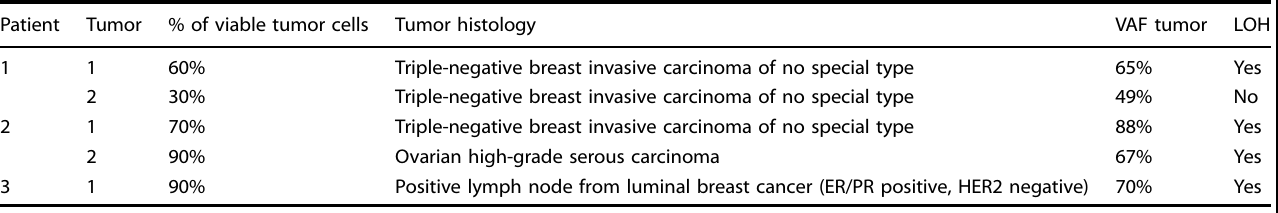
Table 5. Loss of heterozygosity analysis of breast and ovarian tumors of family 1 carriers.